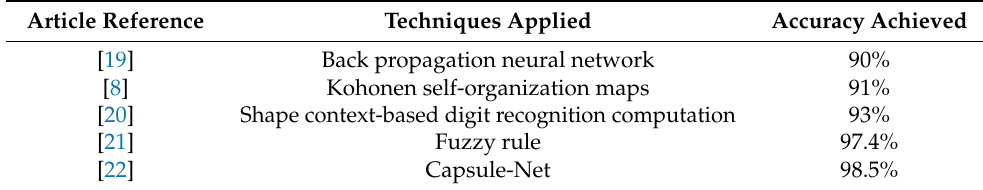
Table 1. Accuracy reported on different